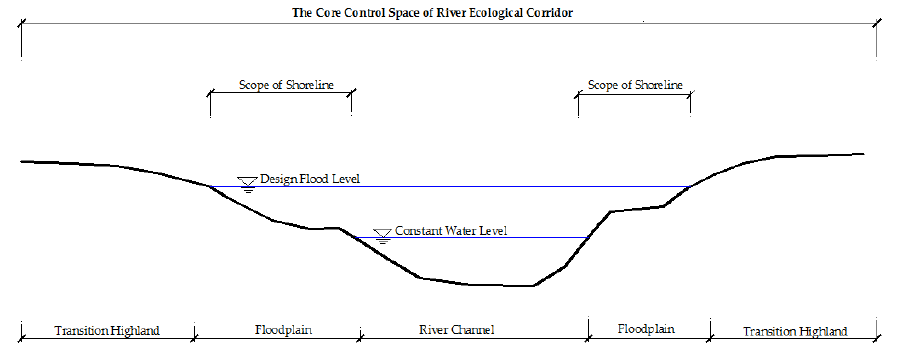
Figure 6. The core control area of the embankment ‐ free section. In this section of no embankment, the width of the transition zone at the edge of the highland needs to be set on the basis of the shore ‐ line, in order to control the negative impact of human activities on the river ecological